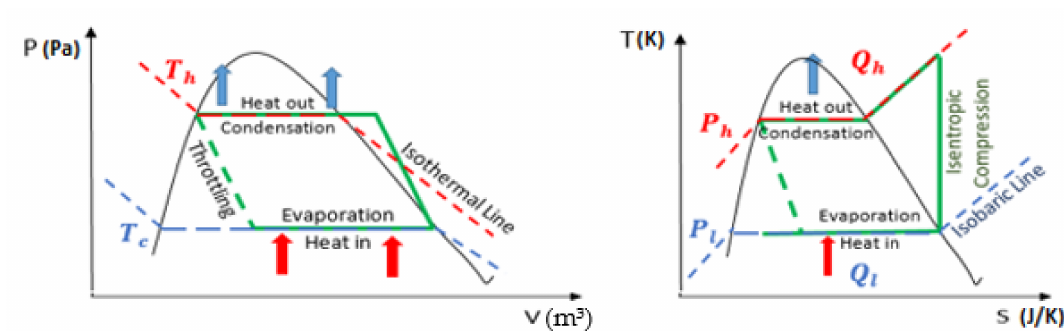
Figure 1. Refrigeration cycle basic working process [26].